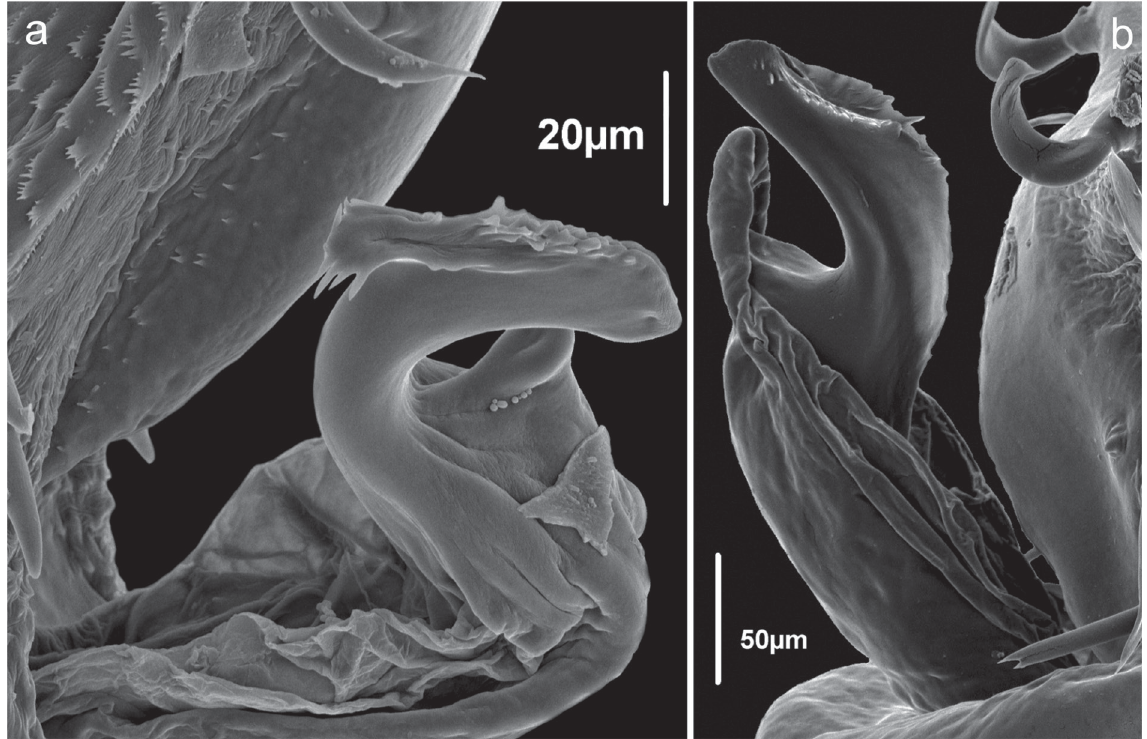
Fig. 17. Penis glans and stylus, lateral view. a . Prostygnus sp., Cranaidae: Prostygninae (MZUSP 57274). b . Flirtea quinquilineata (Simon, 1879), Cosmetidae: Cosmetinae